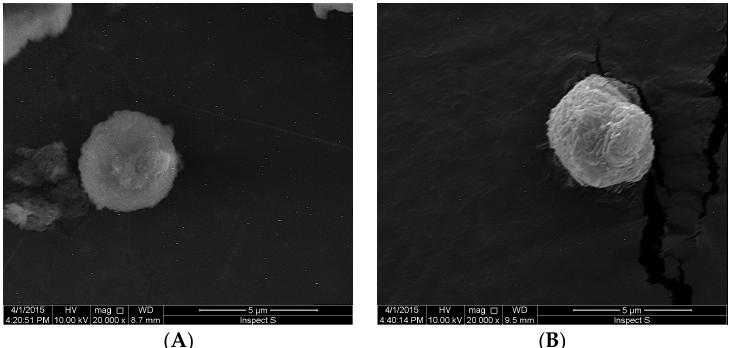
Figure 3. Representative SEM images of S-SEDDS microparticles: ( A ) formulation OF2; ( B ) formulation CF3 (magnification 20,000×).